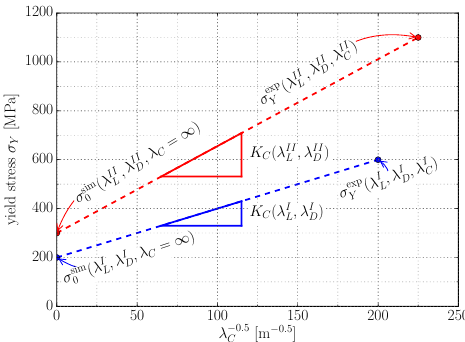
) by combination of simulation and , λ i L D and λ i . With L D exp i i i i i sim ) = σ L , λ D , λ L , λ D ) C ) − σ 0 ( λ Y ( λ , λ i is evaluated. L D λ i − 0.5 C